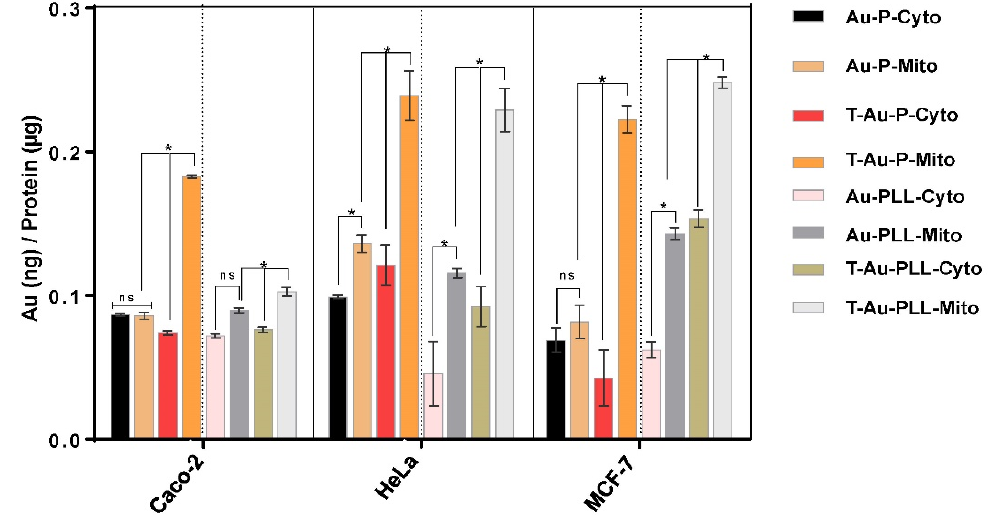
Figure 6. Cytosolic and mitochondrial distribution of mitochondrial targeted and nontargeted nanoparticles as determined by ICP-OES. Data is represented as mean ± SD ( n = 3); * p < 0.05; ns = no significant difference.